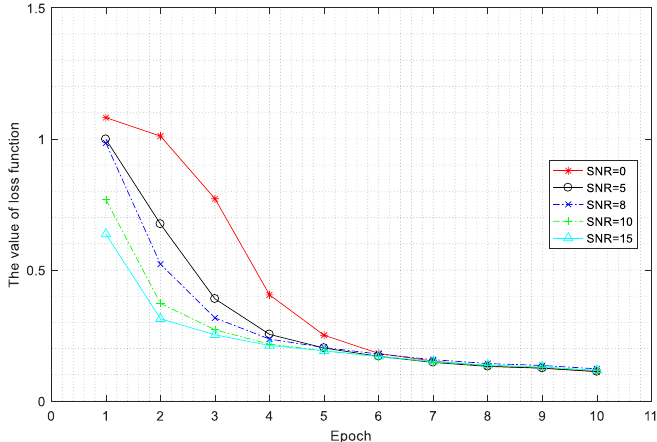
Figure 15. The value of the loss for di ff erent signal-to-noise ratios (SNRs) over training epochs.